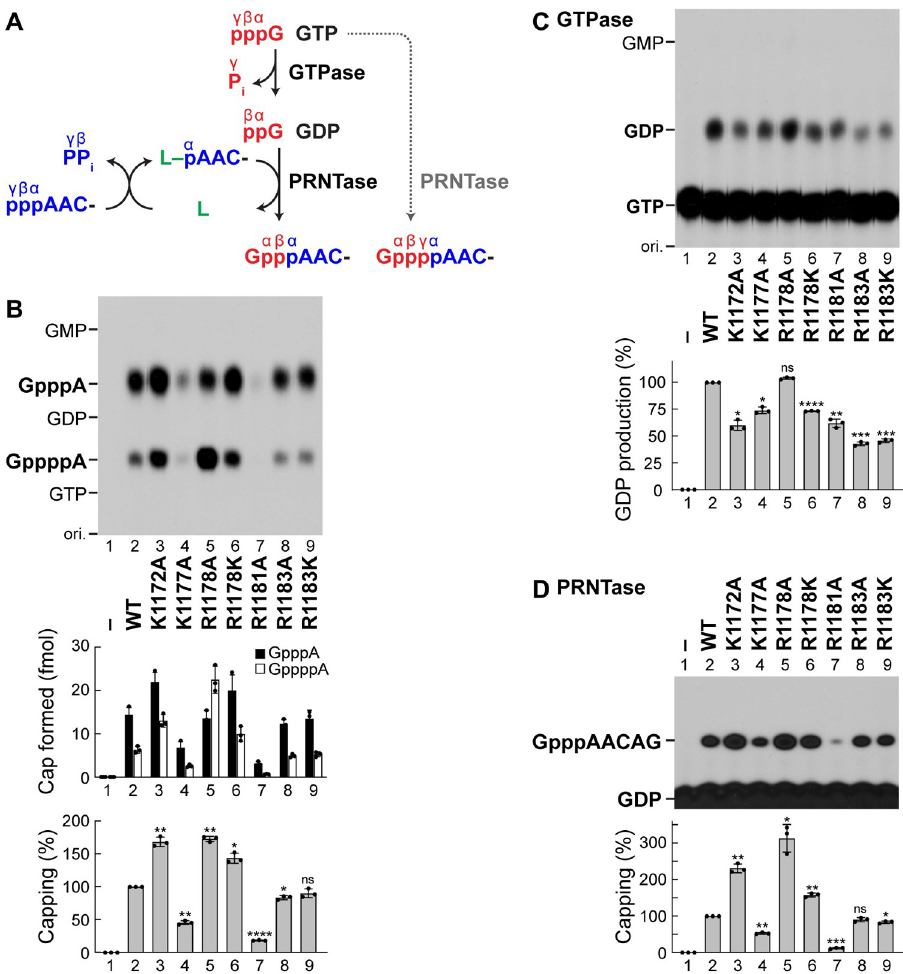
Fig 2. Mutations of the semiconserved basic amino acid residues in the α -helix structure do not abolish the cap- forming activities of the VSV L protein. ( A ) The unconventional pathway of the VSV mRNA cap formation is schematically depicted. The guanosine 5 0 -triphosphatase (GTPase) activity associated with the VSV L protein hydrolyzes GTP (pppG) into GDP (ppG). The GDP polyribonucleotidyltransferase (PRNTase) domain of the VSV L protein transfers 5 0 -monophosphorylated RNA (pAAC-) from 5 0 -triphosphorylated RNA (pppAAC-) to GDP to generate the cap core structure G(5 0 )ppp(5 0 )A- (center product). When pAAC- is transferred to GTP, G(5 0 )pppp(5 0 )A- is formed (right product). GTP and RNA are shown in red and blue, respectively. The positions of 5 0 -phosphate groups are labeled by α , β , and γ . P i and PP i indicate inorganic phosphate and pyrophosphate, respectively. L denotes the L protein. ( B ) The in vitro capping assay was performed with recombinant VSV L protein (WT or mutant), [ α - 32 P]GTP, and pppAACAG oligo RNA. Alkaline phosphatase- and nuclease P1-resistant products were analyzed by PEI-cellulose TLC followed by autoradiography (top). Lane 1 indicates no L. The positions of the origin (ori.), GpppA, GppppA, GMP, GDP, and GTP are shown. Amounts of GpppA and GppppA (closed and open columns, respectively) formed on RNA are indicated (middle). Relative cap (GpppA + GppppA) formation activities of the mutants are expressed as percentages of the activity of the WT L protein (bottom). The dot-plots, columns, and error bars represent the individual values, means, and standard deviations, respectively (n = 3). Statistical significance was determined by one- way ANOVA [ns, not significant (p � 0.05); � , p < 0.05; �� , p < 0.01; ��� , p < 0.001; ���� , p < 0.0001; compared to control (WT)]. ( C ) The in vitro GTPase assay was carried out with recombinant VSV L protein (WT or mutant) and [ α - 32 P]GTP. The reaction mixtures were analyzed by PEI-cellulose TLC followed by autoradiography (top). Relative GTPase activities of the mutants are expressed as percentages of the activity of the WT L protein (bottom). ( D ) The in vitro capping assay was performed using [ α - 32 P]GDP, instead of [ α - 32 P]GTP, as a pRNA acceptor substrate to measure PRNTase activities of the WT and mutant L proteins independently of their GTPase activities. Capped RNA products were analyzed by 20% urea-PAGE followed by autoradiography (top). Relative cap (GpppA) formation activities of the mutants are expressed as percentages of the activity of the WT L protein